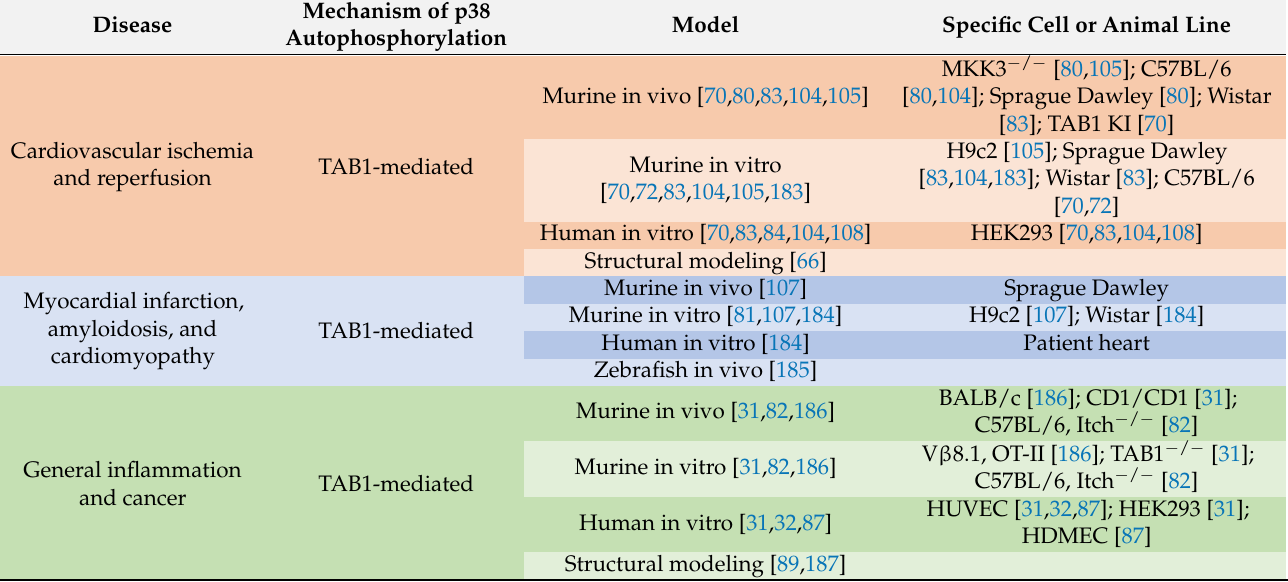
Table 3. Physiological roles of TAB1-dependent atypical p38